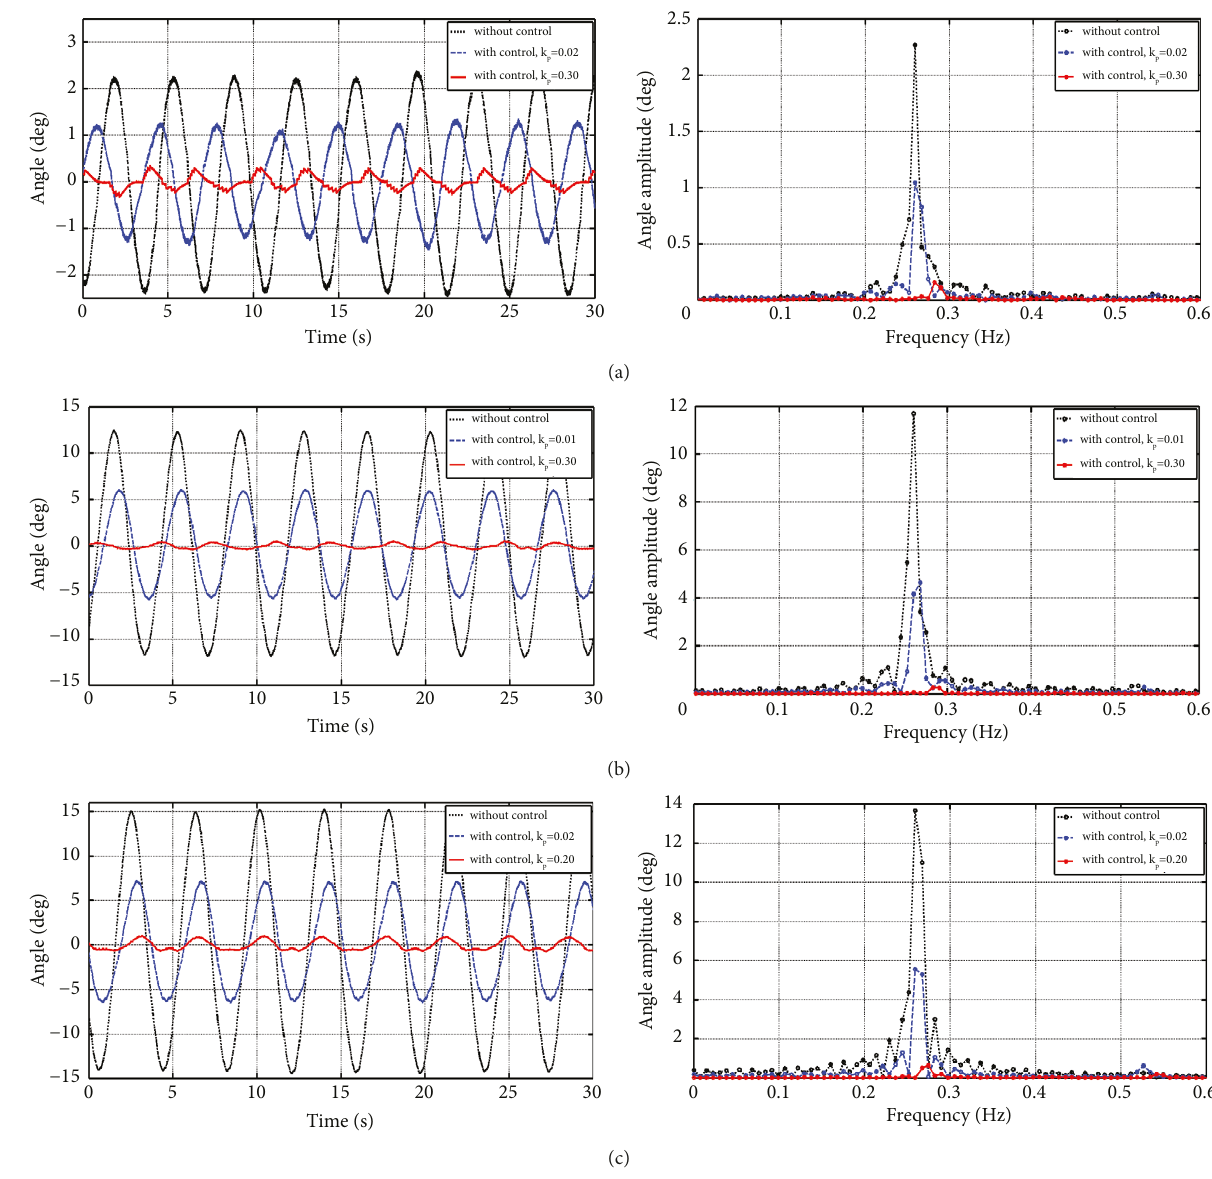
Figure 9: Vibration control Experiment I excitation at 0.26Hz. Table 3: Vibration control effect based on the novel active joint in Experiment I . Experiment